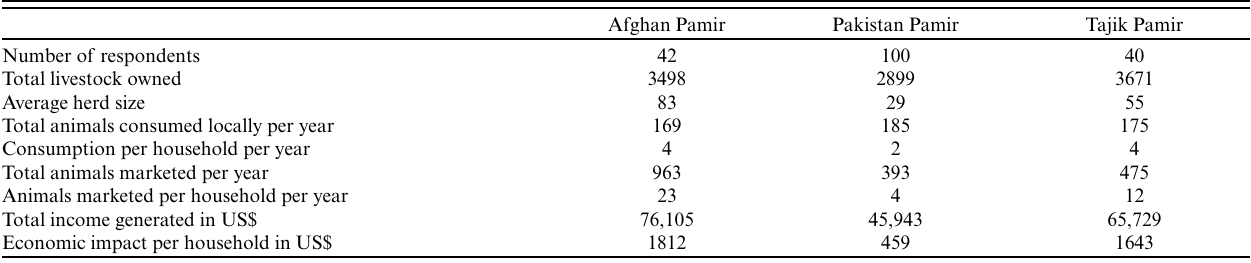
Table 1 . Livestock holding, local consumption, and economic valuation of livestock owned by the respondents